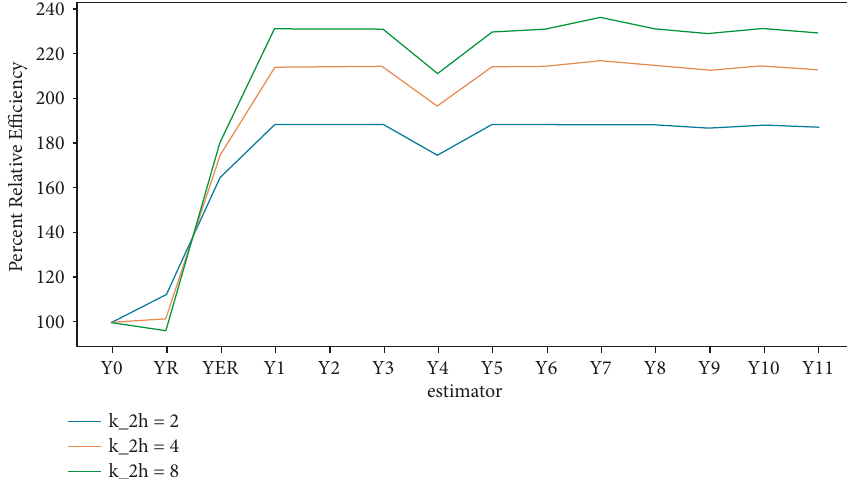
Figure 3: Plot of PREs at 30% nonresponse and 0.2 sensitivity level for population I.